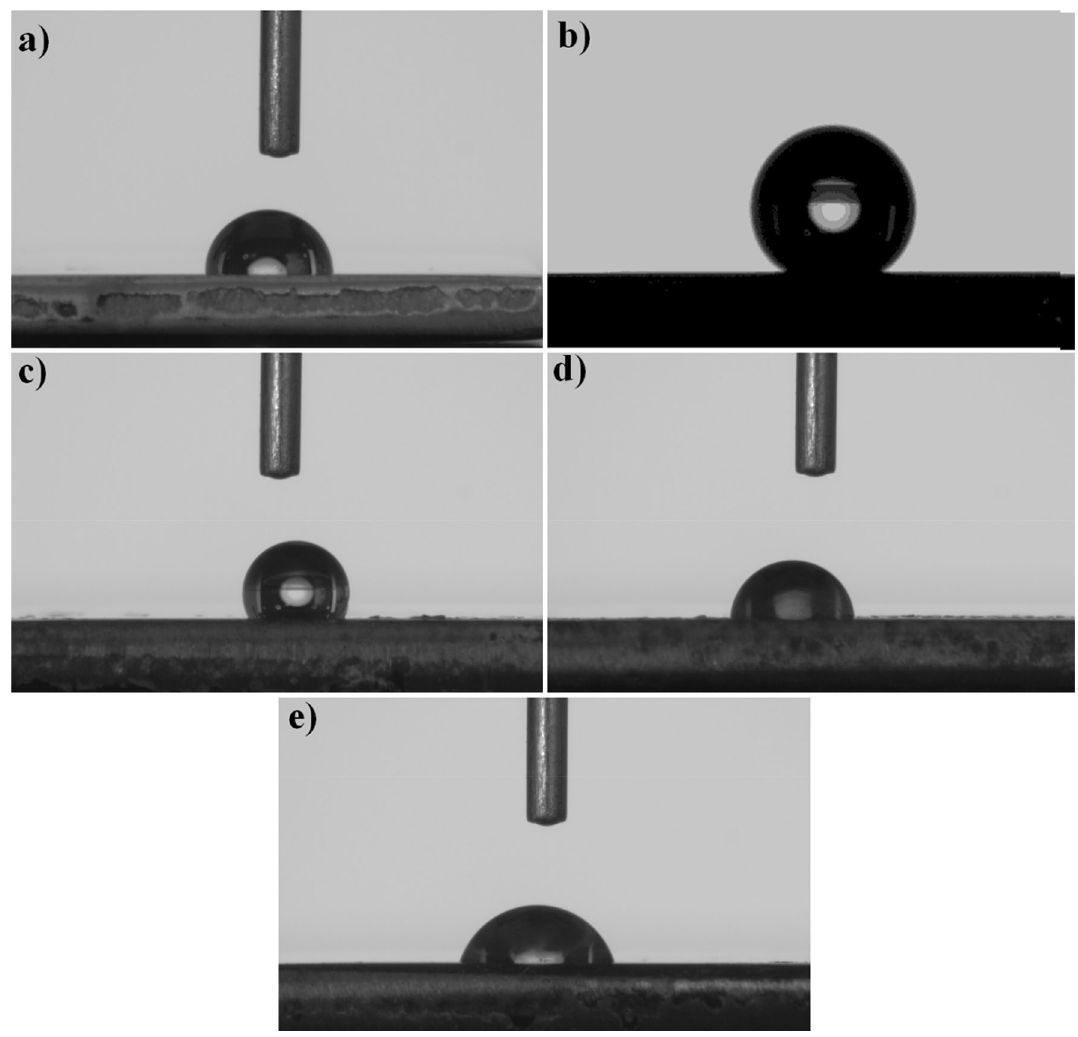
Figure 4. Contact angle images of the surfaces: ( a ) bare Gr2, ( b ) bare TiO 2 nanotube, ( c ) Gr2-50 V-Ag-0.5 m, ( d ) Gr2-50 V-Ag-1 m and ( e ) Gr2-50 V-Ag-5 m.